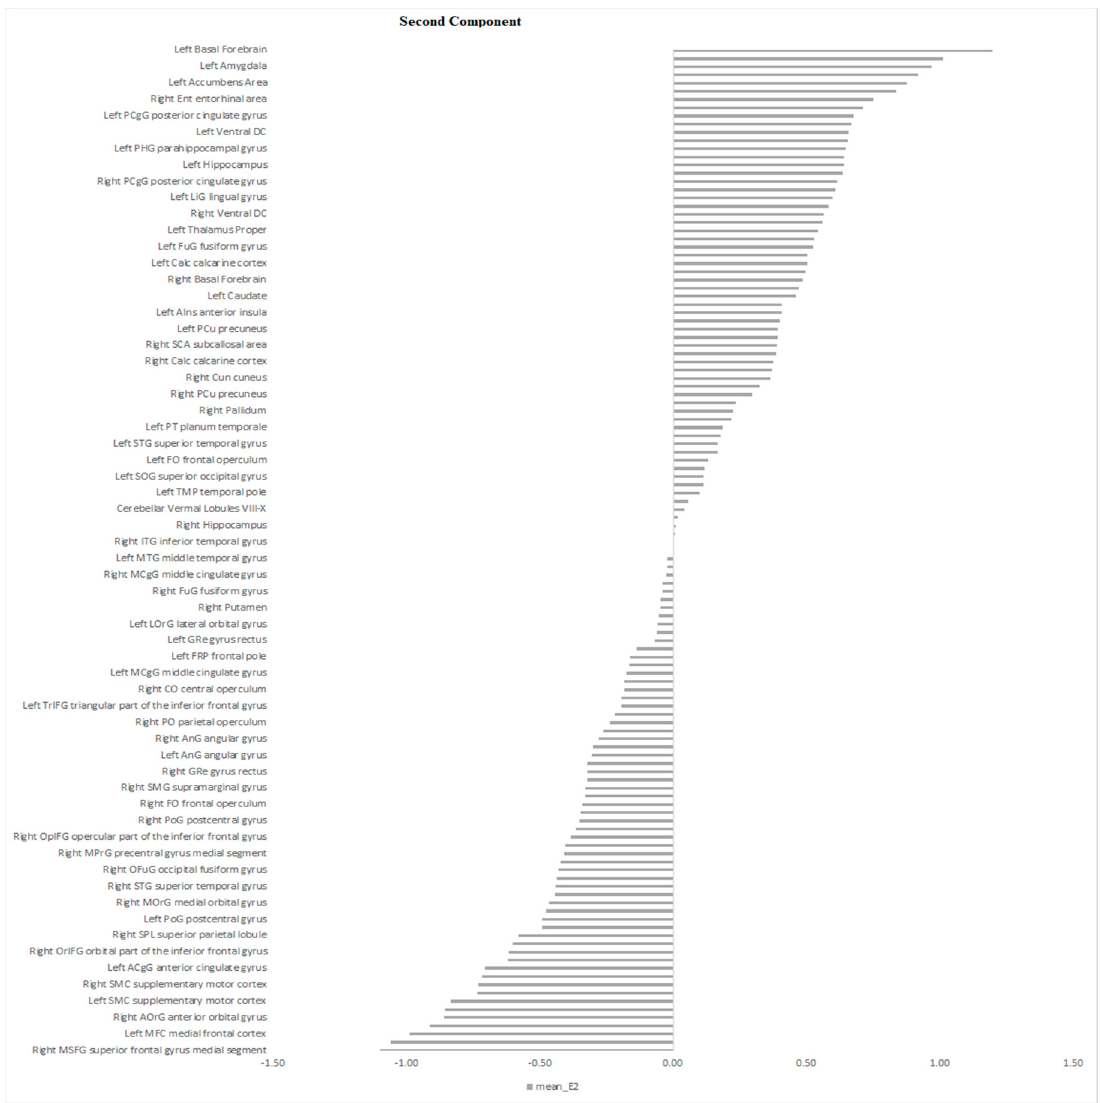
Figure 5. The bars plot shows the average contribution for the Secondcomponent/Eigenimage computed at the regional level using the Neuromorphometric atlas. The higher the value the higher the contribution positively or negatively.